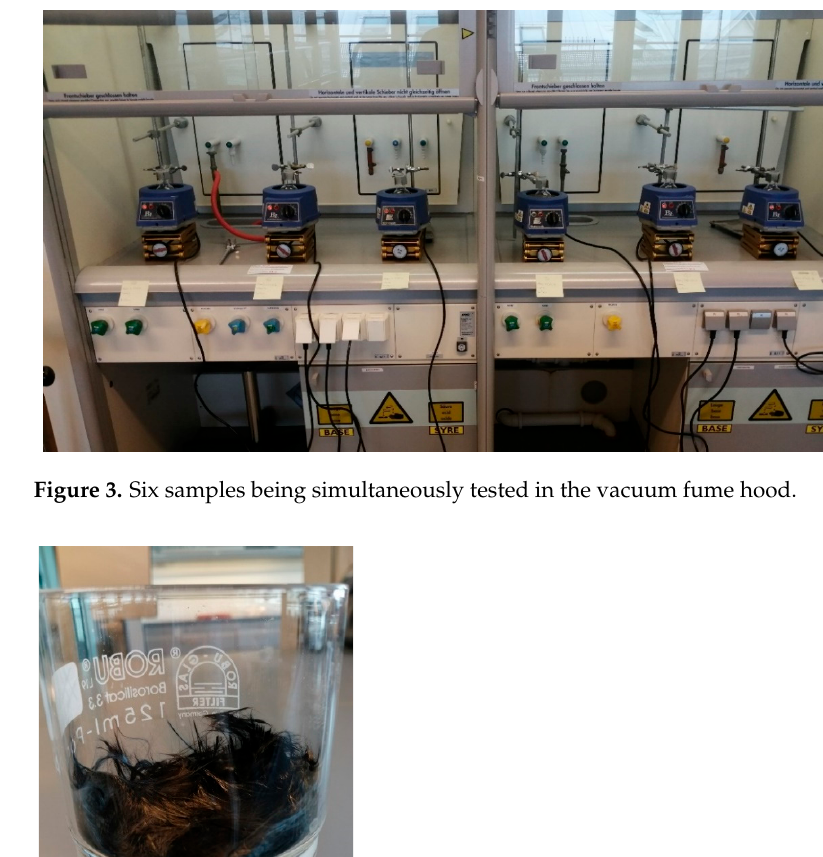
Figure 3. Six samples being simultaneously tested in the vacuum fume hood.